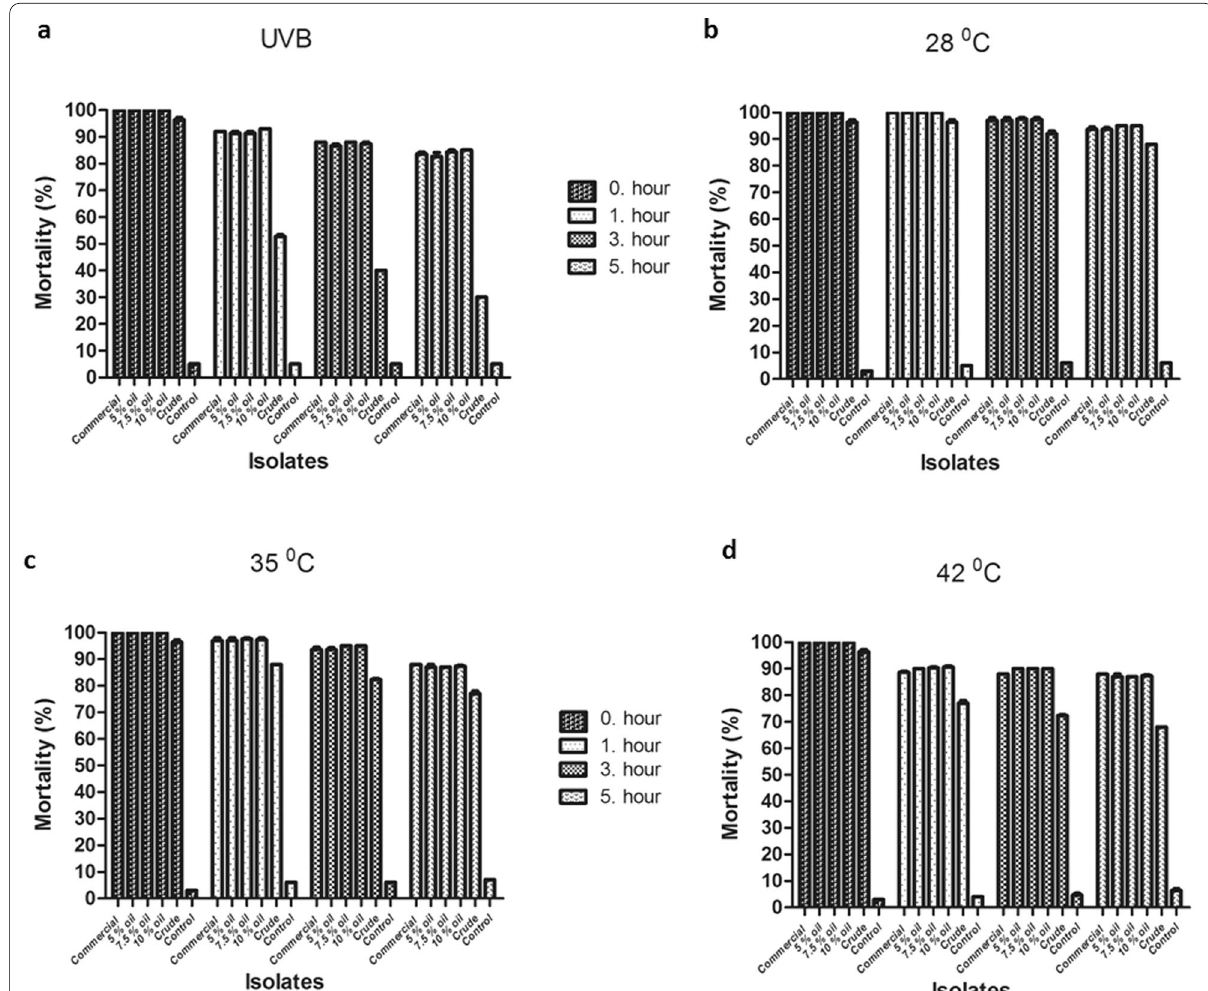
Fig. 1 Mortality rates after UV-B and temperature application of crude virus, oil contain formulations, and commercial product against 3rd instar Helicoverpa armigera larvae. a UV-B, b 28, c 35, and d 42